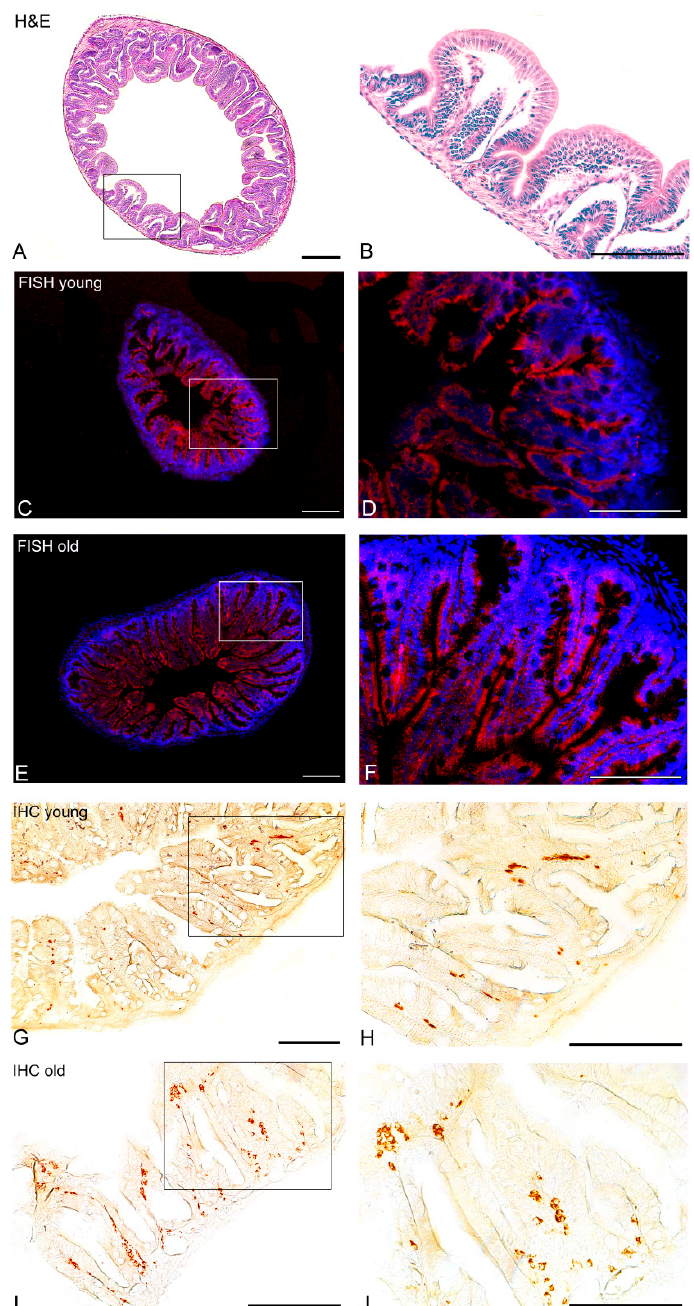
Figure 7. Transversal section showing localization of NUCB2B mRNA and Nesf-1 protein in the rostral intestinal bulb of N. furzeri . ( A ) Hematoxylin / eosin staining reveals a simple architecture of a mucosa, submucosa, muscularis externa, and serosa layer; ( B ) Higher magnification of A; ( C ) in young fish NUCB2B mRNA was detected in the lining epithelium; ( D ) Higher magnification of C; ( E ) in old fish, NUCB2B mRNA was detected in the lining epithelium; ( F ) Higher magnification of E; ( G ) in young subjects, Nesf-1-immuonoreactivity (ir) was detected within rounded or flask-shaped cells in submucosa, most of them scattered deep within the folds of the ridges; ( H ) Higher magnification of G; ( I ) in old fish, Nesf-1-ir cells were more abundant in the submucosa and in addition, some of the cells were dispersed along the apical regions of the ridges; ( J ) Higher magnification of I. Scale bars: